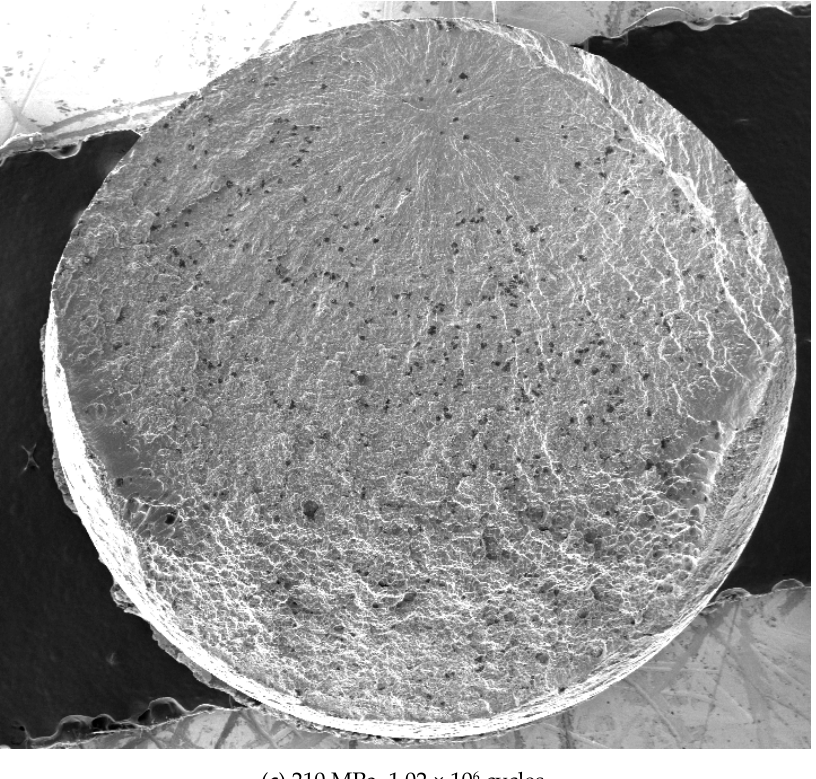
Figure 6. S–N diagram and fracture surface at room temperature.